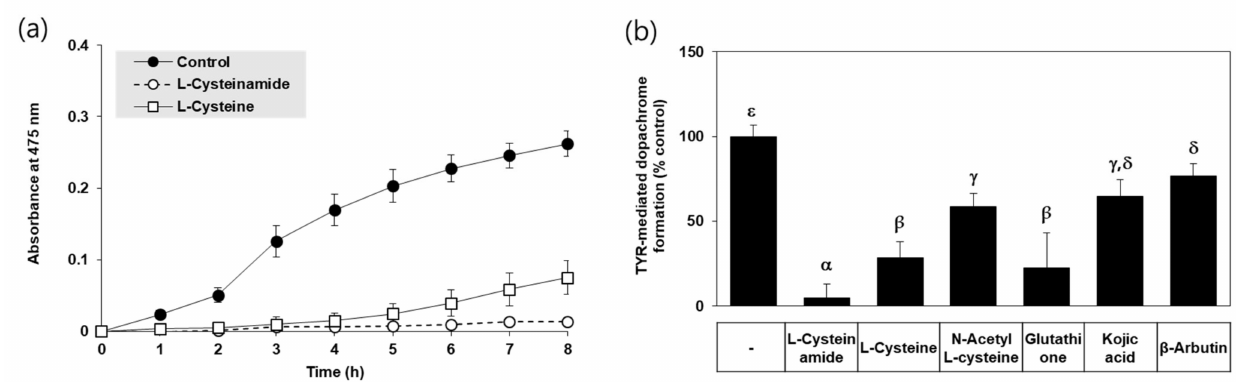
Figure 2. Effects of L-cysteinamide, L-cysteine, N-acetyl L-cysteine, glutathione, kojic acid, and β -arbutin on TYR-mediated dopachrome formation in vitro. ( a ) Time-dependent changes in A 475 of the TYR reaction mixture in the absence (control) or presence of L-cysteinamide or L-cysteine at 0.2 mM ( n = 3). ( b ) TYR-mediated dopachrome formation determined in the absence (control) and presence of each substance at 0.2 mM ( n = 4). Data are presented as % of control (means ± SD). Duncan’s multiple range test was performed to compare all group means to each other. Groups that share the same Greek letters ( α , β , γ , δ , or ε ) do not have significantly different means at the p < 0.05 level.